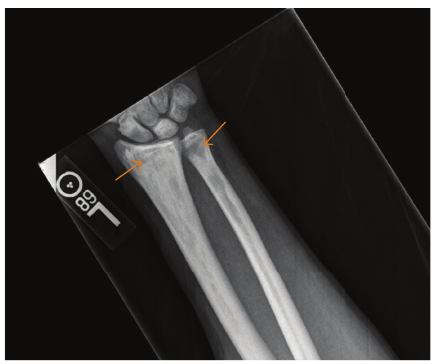
Figure 3: A 35-year-old male with frontal radiograph of the distal right forearm: there is permeative mixed sclerosis and lucency in the distal radial and ulnar metaphysis and epiphysis (arrows). Similar findings were present on the contralateral side.